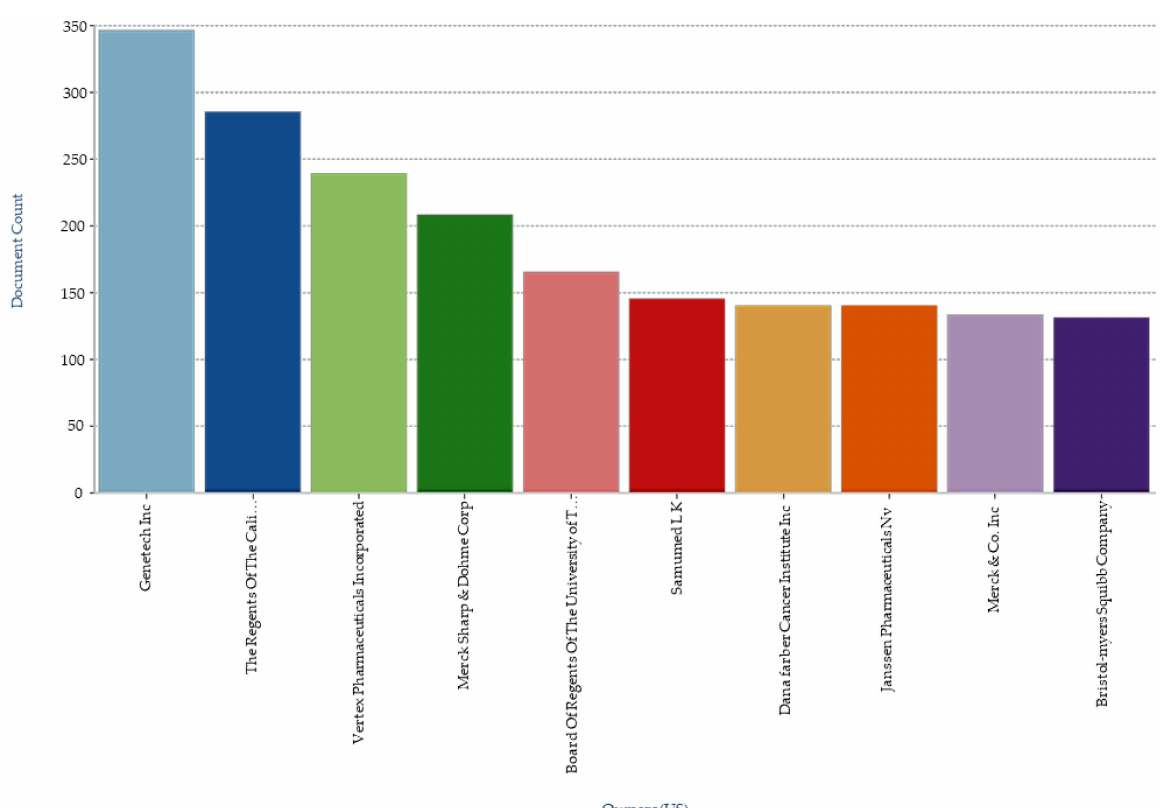
Figure 12. Top US owners of patents related to